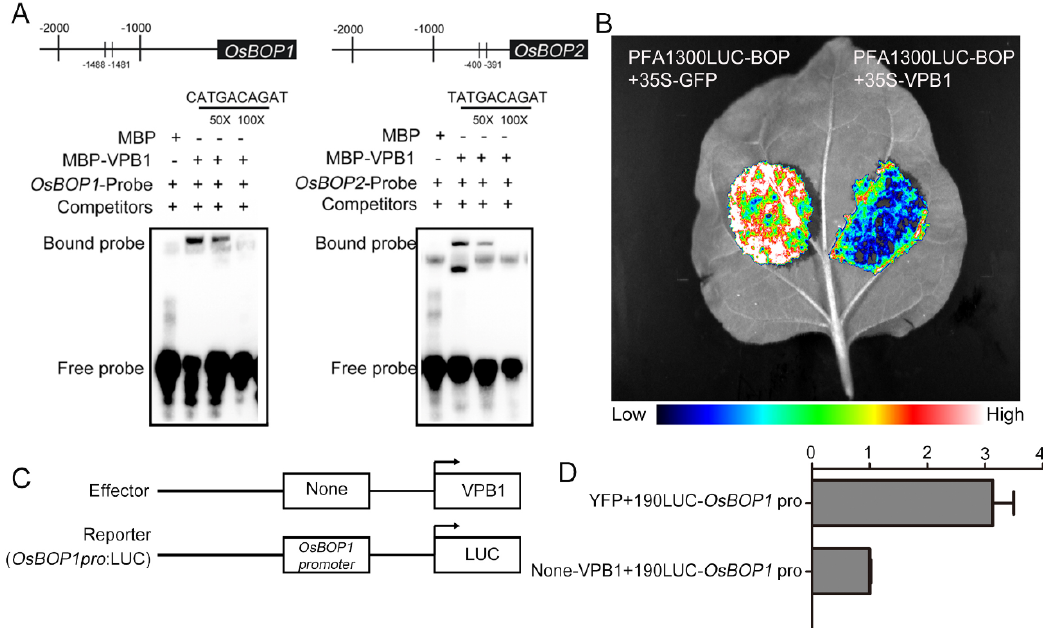
Figure 9. VPB1 is the transcriptional repressor of OsBOP1 . ( A ) Schematic diagram of the OsBOP1/2 promoter showing the potential VPB1 binding sites and EMSA of MBP and MBP—VPB1 recombinant proteins incubated with biotin—labeled probes of OsBOP1 and OsBOP2 . Numbers above the diagram indicate the distance away from ATG. Competition for binding was performed using 50× and 250× competitive probes; MBP was used as a negative control. ( B ) Analysis of the binding ability of VPB1 with the OsBOP1 promoter transiently expressed in tobacco leaves by transient expression regulation assays, showing that VPB1 protein suppresses the expression of OsBOP1 . ( C ) Scheme of the constructs used in the protoplast dual luciferase reporter assays. ( D ) Dual luciferase reporter assays in rice protoplasts shows that the VPB1 protein suppresses the expression of LUC gene through binding to the OsBOP1 promoter. Data are mean ± SD ( n = 3 independent replicates).